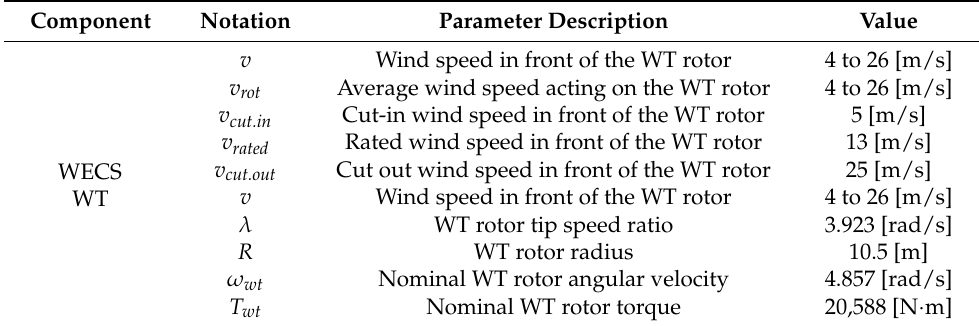
Table A1. Necessary parameters for modeling, defining. the controller and running the simula- tions